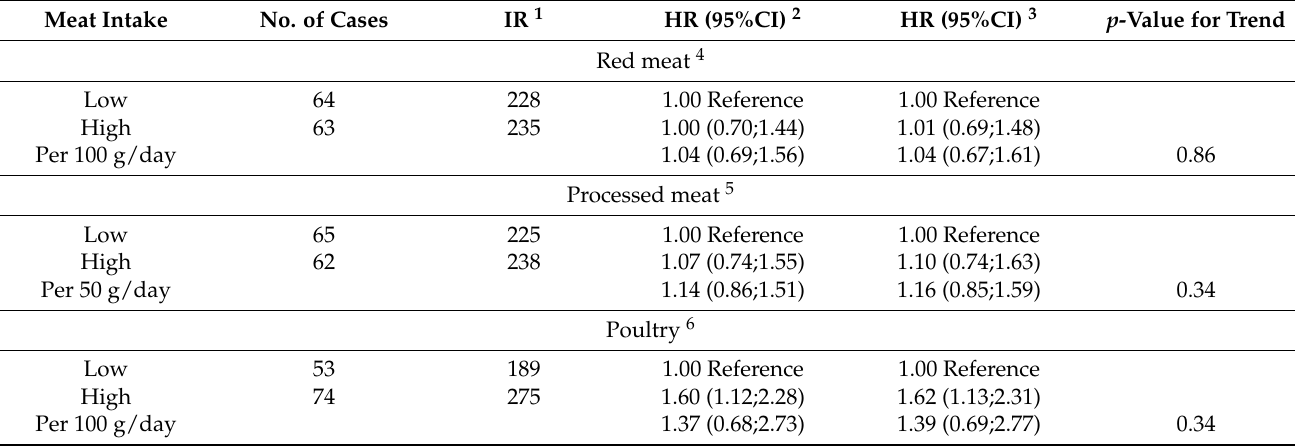
Table 3. Association between intake of different types of meat and risk of colorectal cancer, n = 6282.